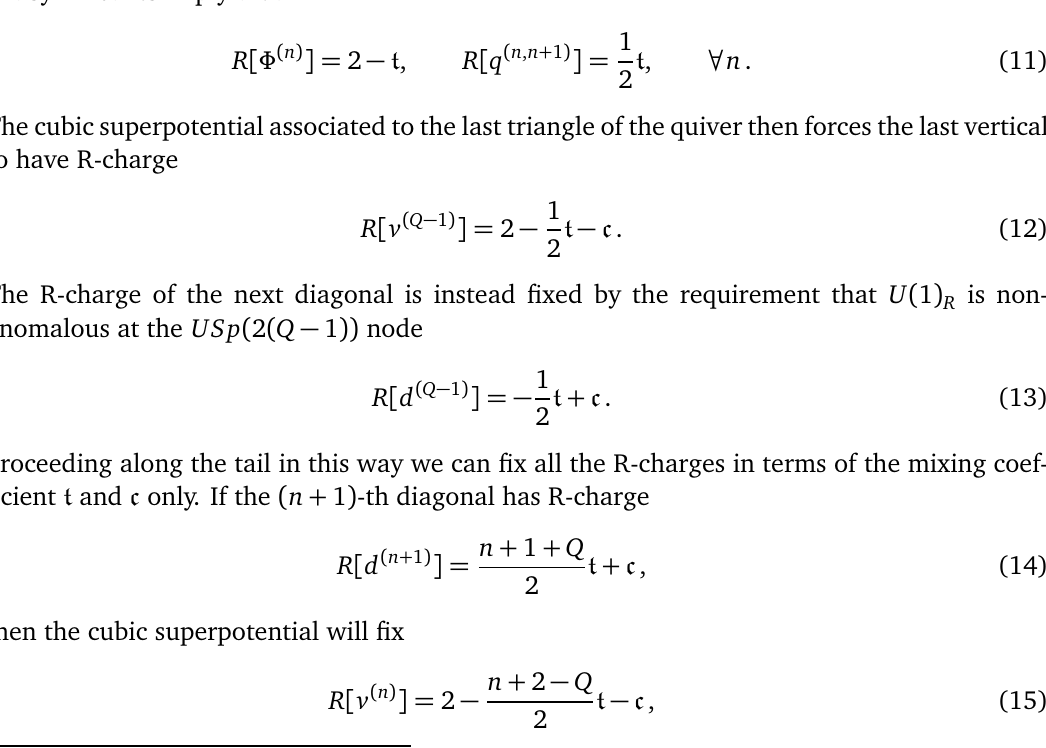
Figure 4: Trial R-charges and charges under U ( 1 ) are given by the exponents of the fugacities c and t